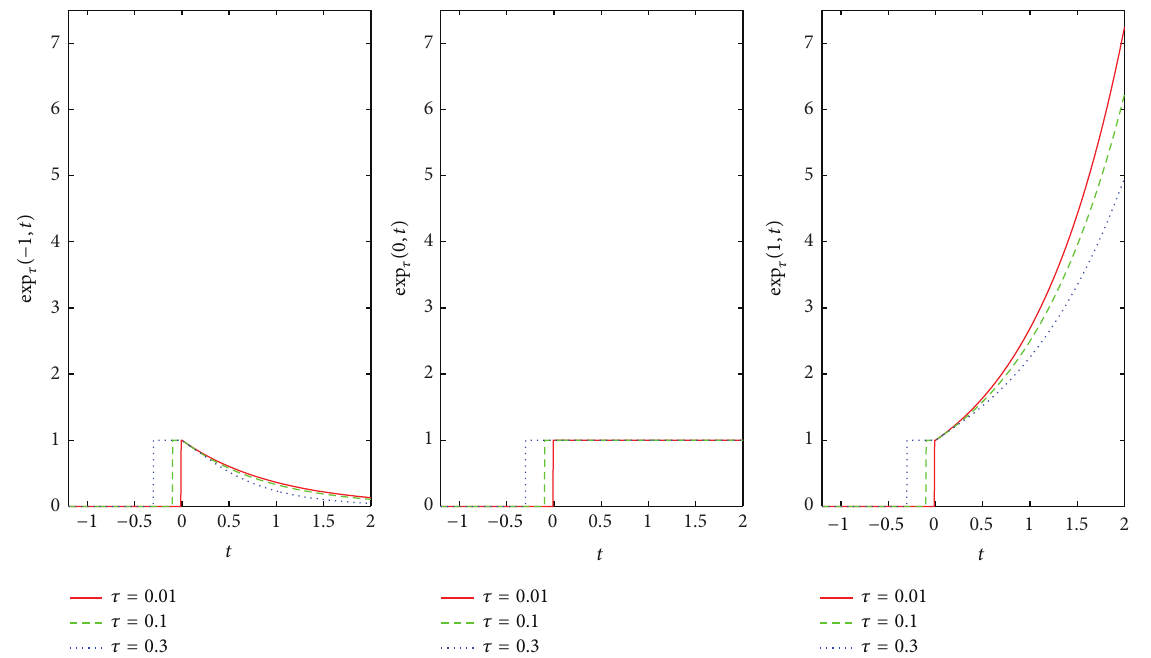
Figure 2: Delayed exponential